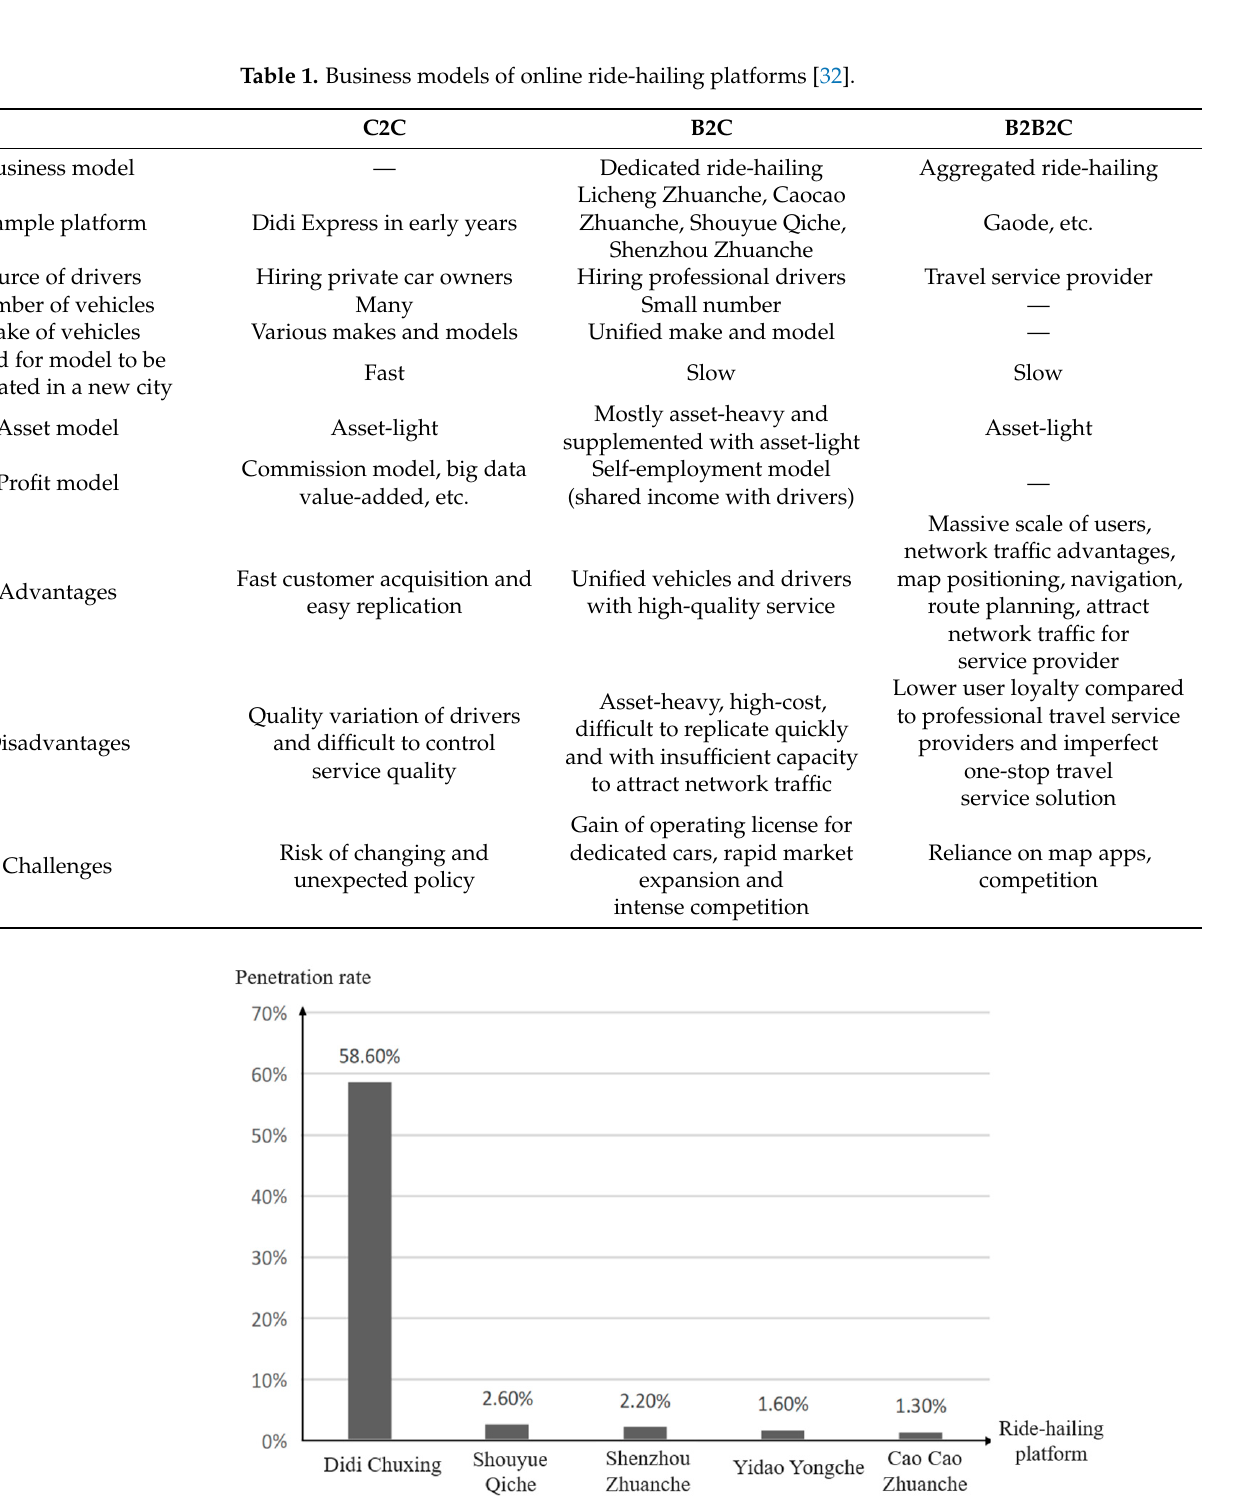
Figure 4. Penetration rate of major online ride-hailing platforms in China in 2017.